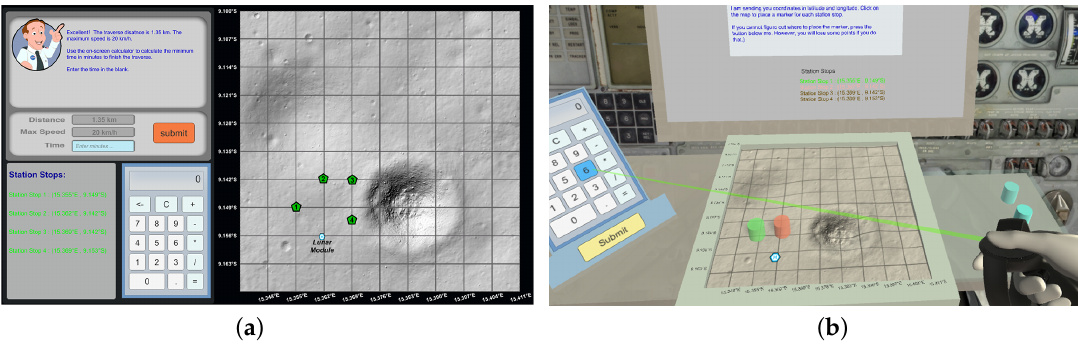
Figure 1. Screenshots of the planning phase. ( a ) is the user interface for the non-virtual reality (VR) version of the game, and ( b ) is the 3D environment for the VR version of the